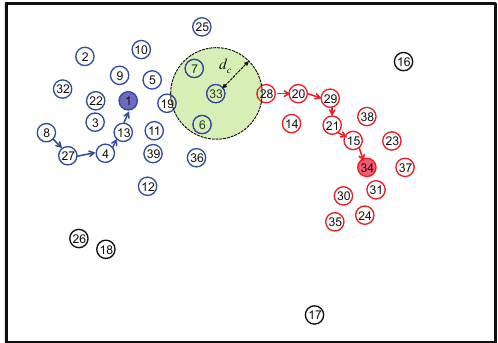
Figure 2: An illustration of the hierarchical clustering procedure. The data points p 1 and p 34 are the cluster centers, the symbol → indicates the pairwise linkage, and the big circle in green denotes the neighborhood set of a data point with a cutoff distance d c